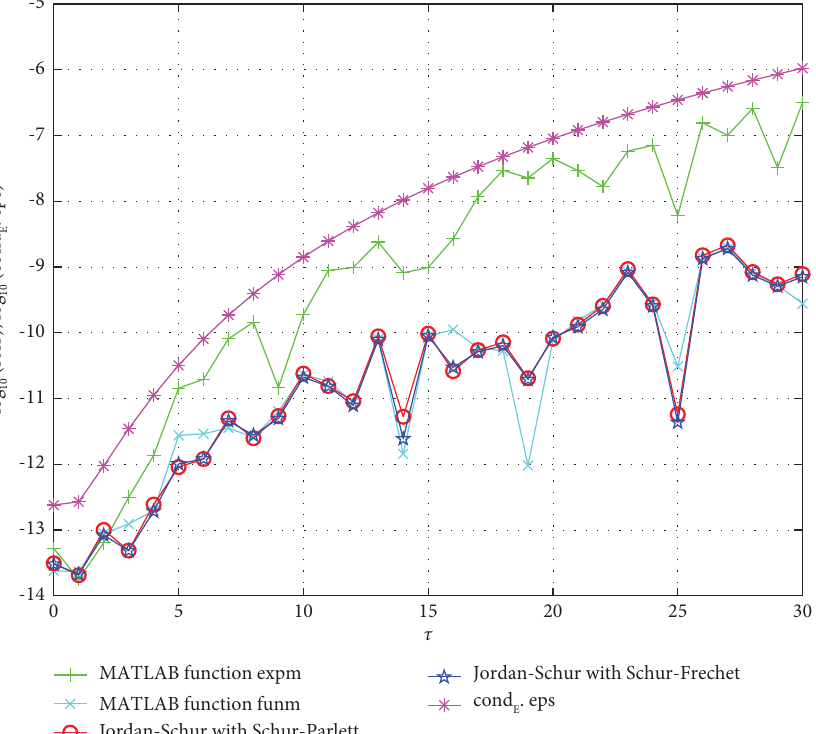
Figure 1: Relative errors for Experiment 1.